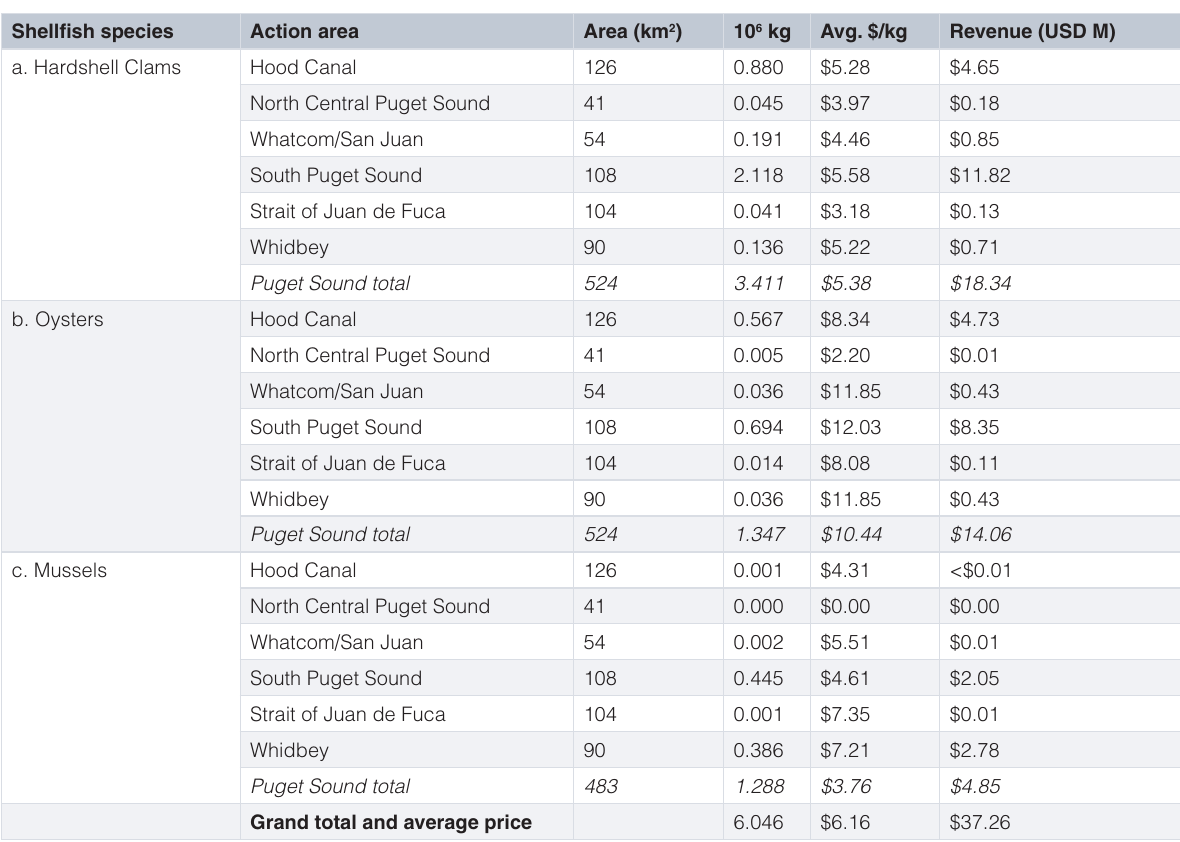
Table 1. Harvest of shellfish species a) hardshell clams, b) oysters, and c) mussels, by PSP action area in Puget Sound, size of harvested area (km 2 ), kilograms of shellfish harvested each year (in millions of kilograms year -1 ; 10 6 kg), average price per kilogram (USD/kg) (data from PacFIN) 55 , and total revenue (in millions of dollars, USD M). Total kilograms of shellfish harvested and revenue in Puget Sound are summed as the grand total for all species, and listed with the average price for all three shellfish across the total harvest shellfish